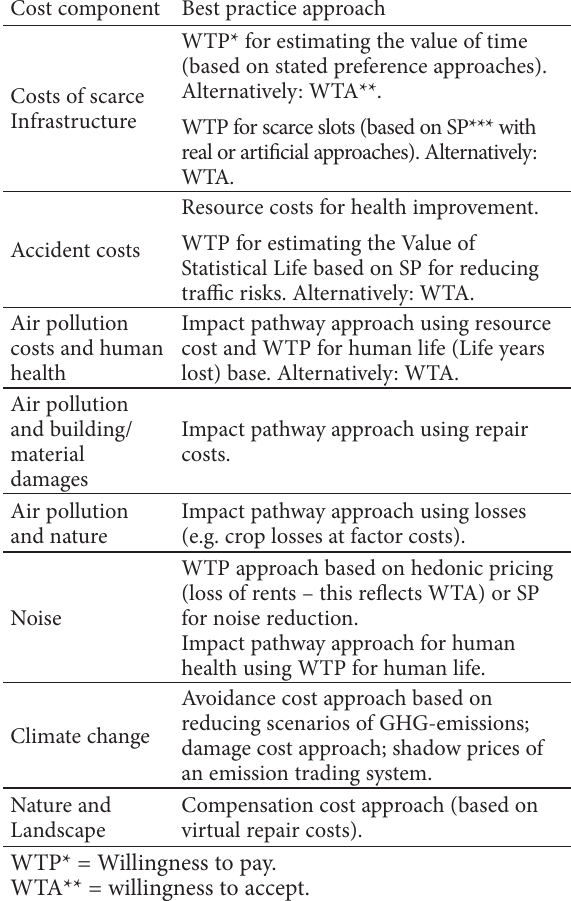
Table 3. Valuation approaches Cost component Best practice